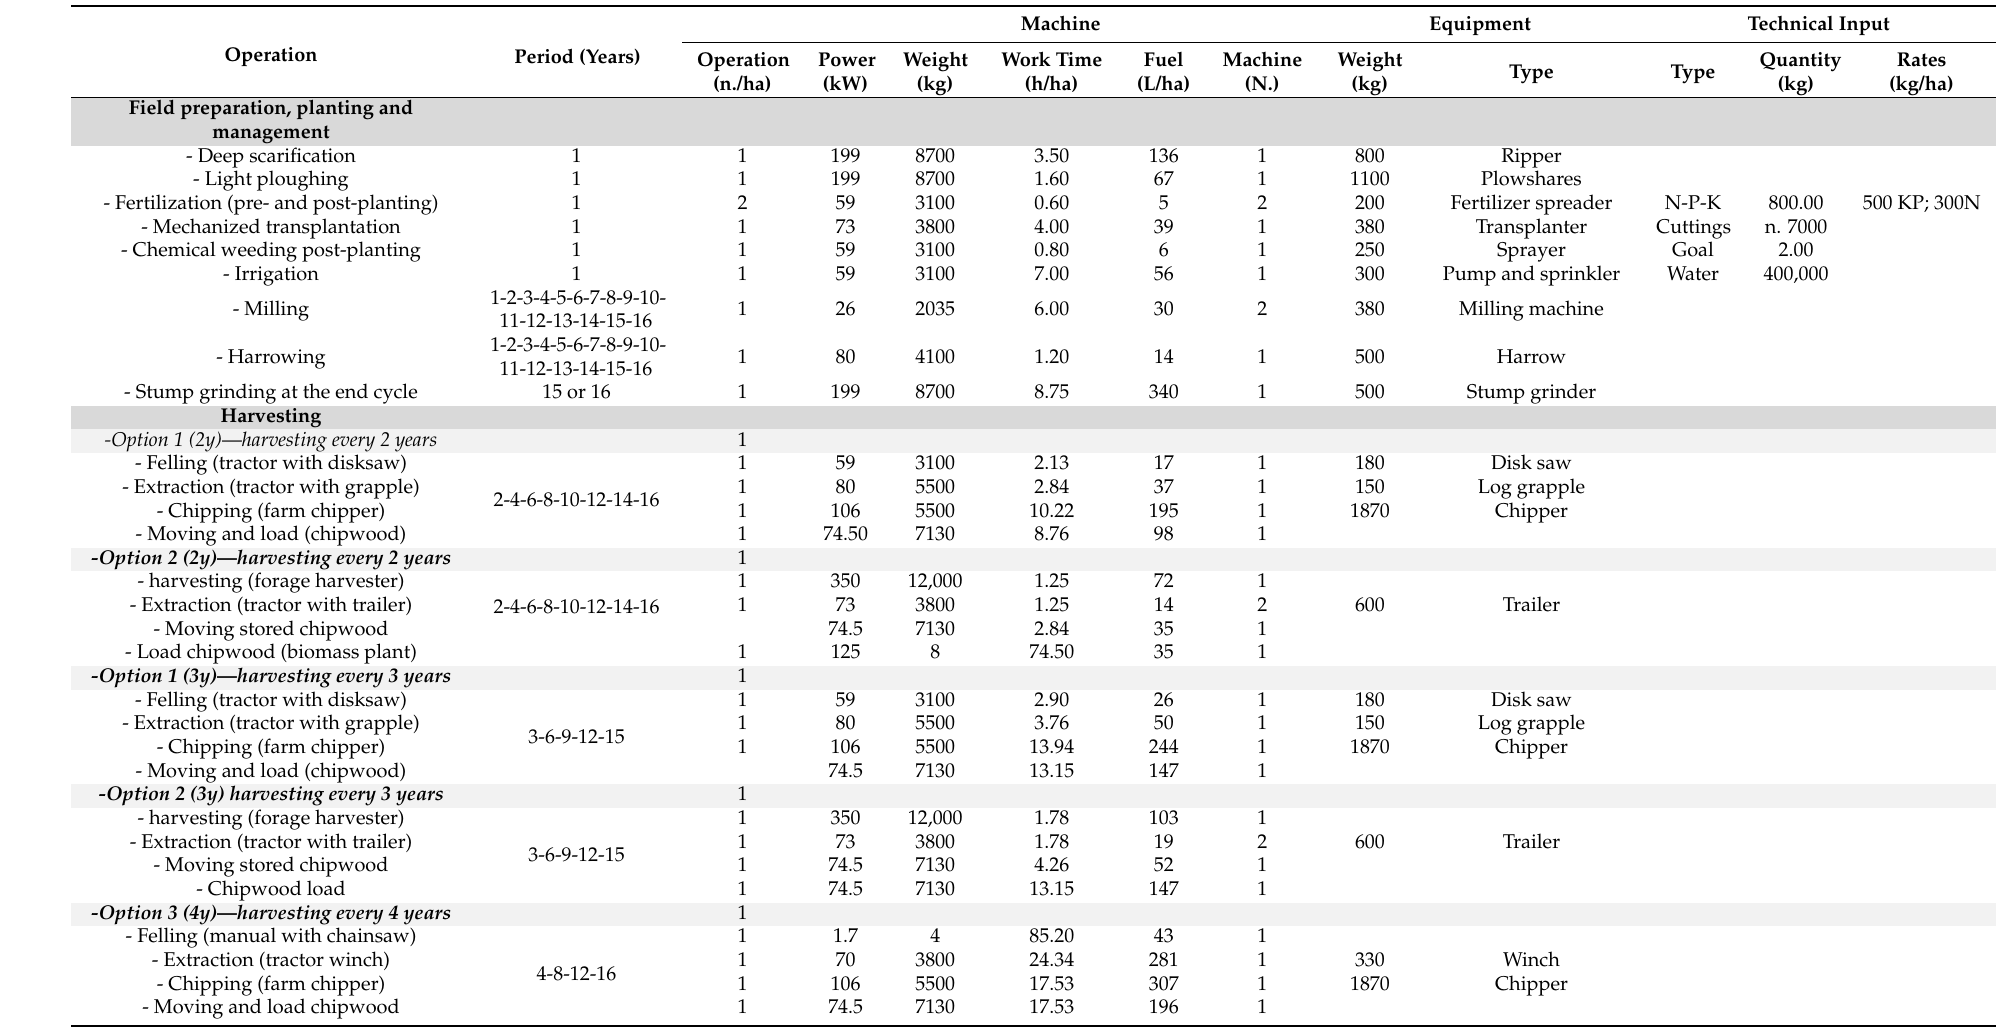
Table 2. Principal technical elements considered in the poplar plantations life